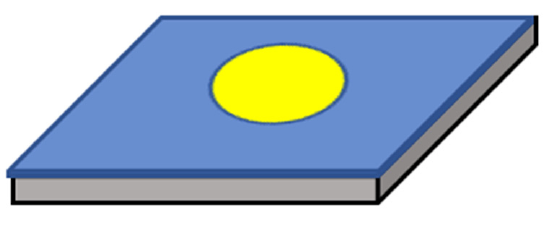
Figure 1. Types of chipless RFID tags (Reprinted with permission from Ref. [25] 2016, John Wiley and Sons) .